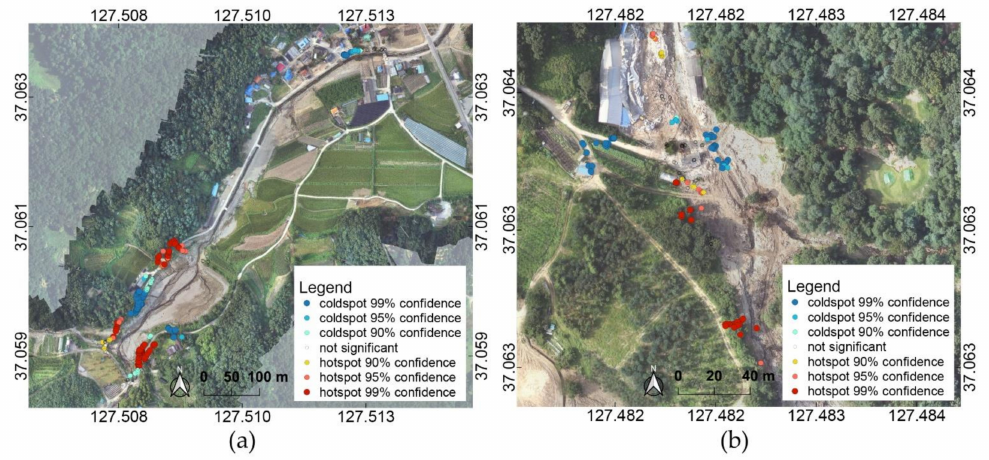
Figure 6. Hotspot analysis on landslide incident using 5 August data: ( a ) Yul and ( b ) Iljuk. The coordinates refer to WGS84 (EPSG: